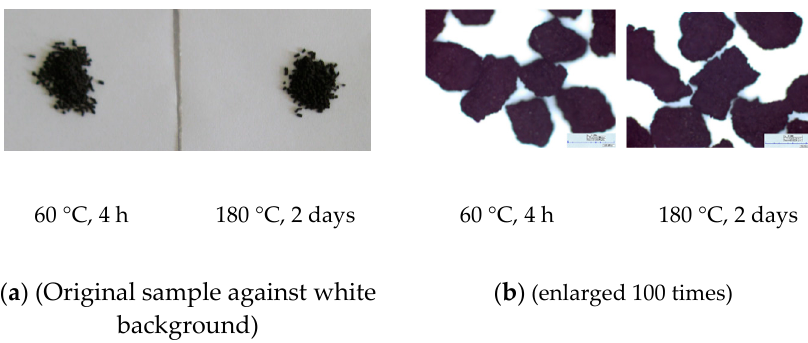
ff erent temperature